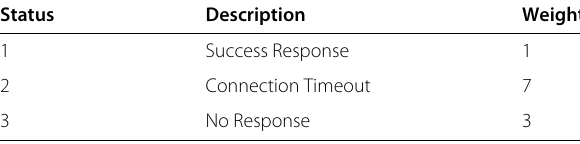
Table 3 Different weight values defined according to the severity of the connection status relative to the DUT